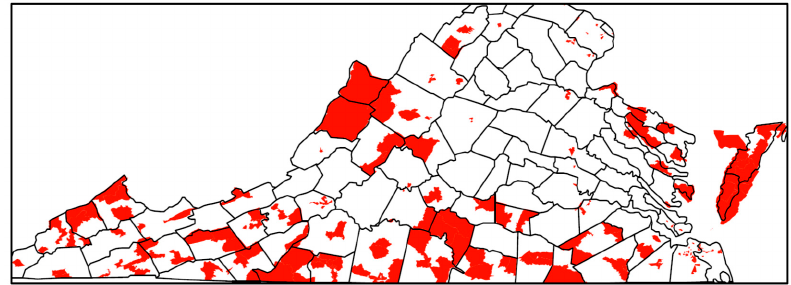
Figure 3. Census tracts with significantly elevated risk of tobacco retail outlets with county boundaries in Virginia, 2018.